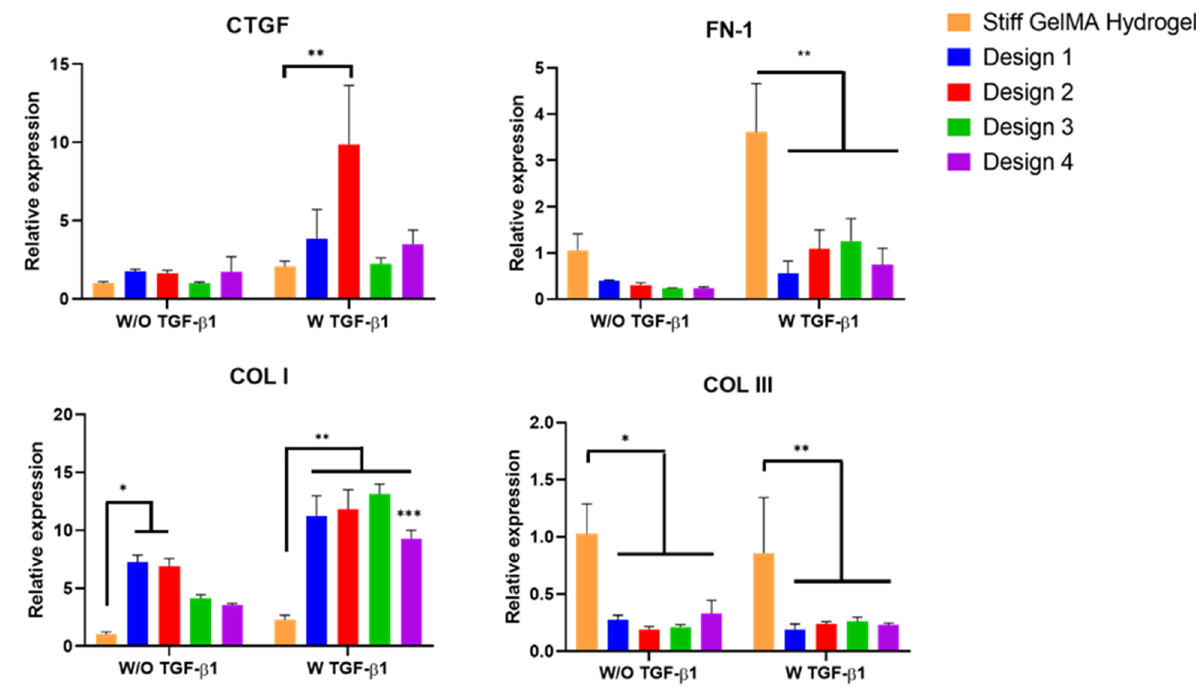
Figure 10. Expression of CTGF, FN, Col I and Col III in four 3D-printed GelMA scaffold designs compared with the bulk stiff GelMA hydrogel at 7 days. * p < 0.05 compared to the stiff GelMA hydrogel in the absence of TGF- β 1, ** p < 0.05 compared to the stiff GelMA hydrogel in the presence of TGF- β 1, ** p < 0.05 compared to design 3 and *** p < 0.05 design 4 in the presence of TGF- β 1.